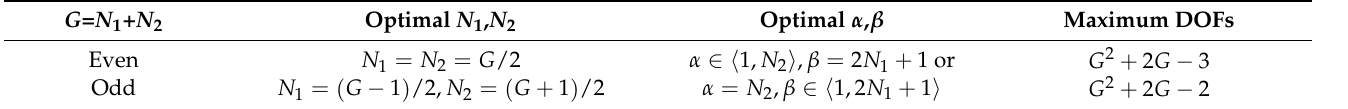
Table 2. Optimal configuration and maximum DOFs for